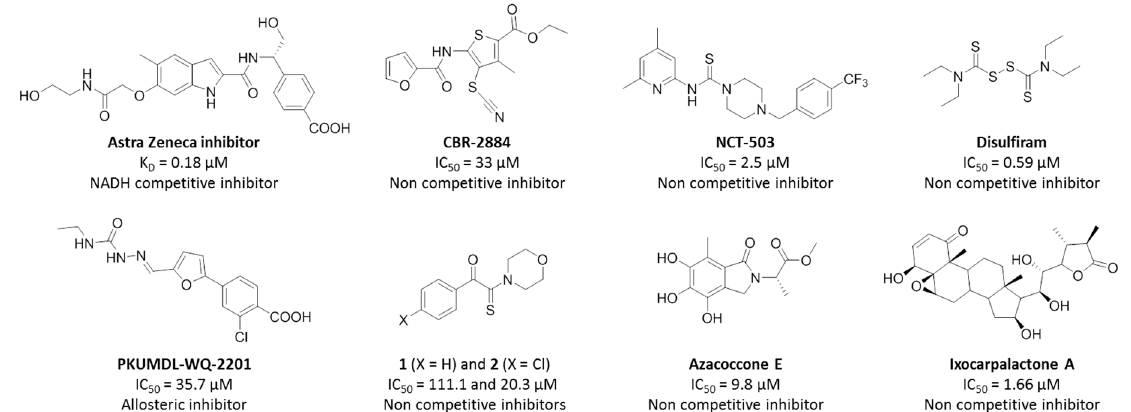
Figure 1. Overview of some reported PHGDH inhibitors.